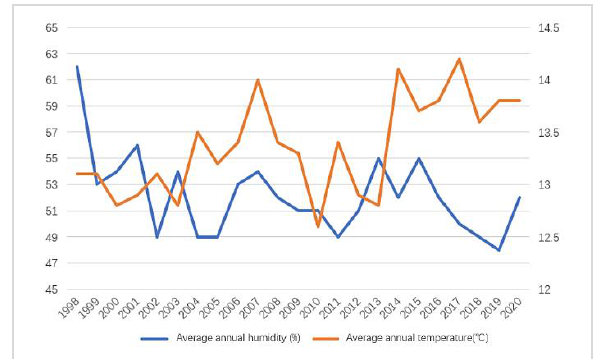
Figure 12. Discounted annual average relative humidity and annual average temperature from 1998 to